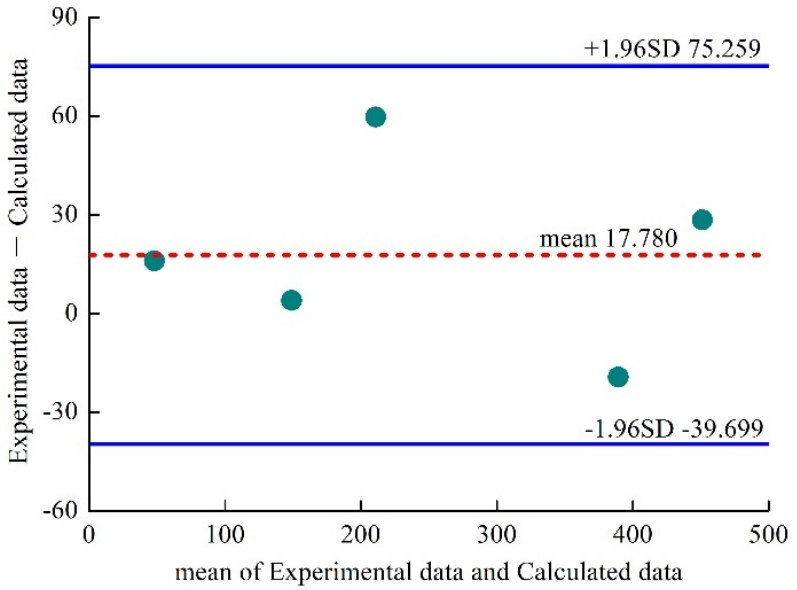
Figure 13. Bland–Altman consistency analysis.